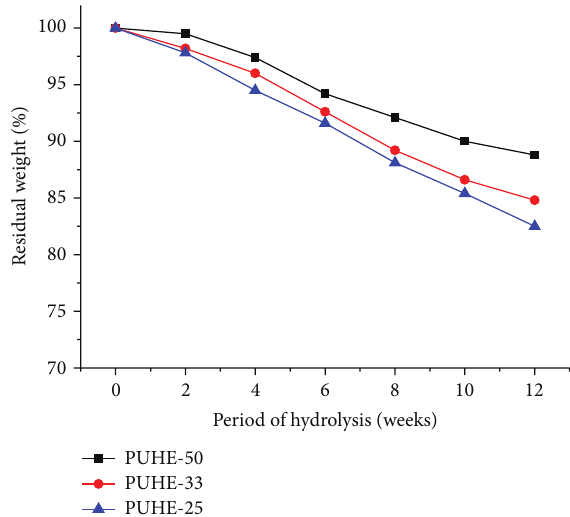
Figure 8: Residual weight (%) of the PUHE films after degradation.